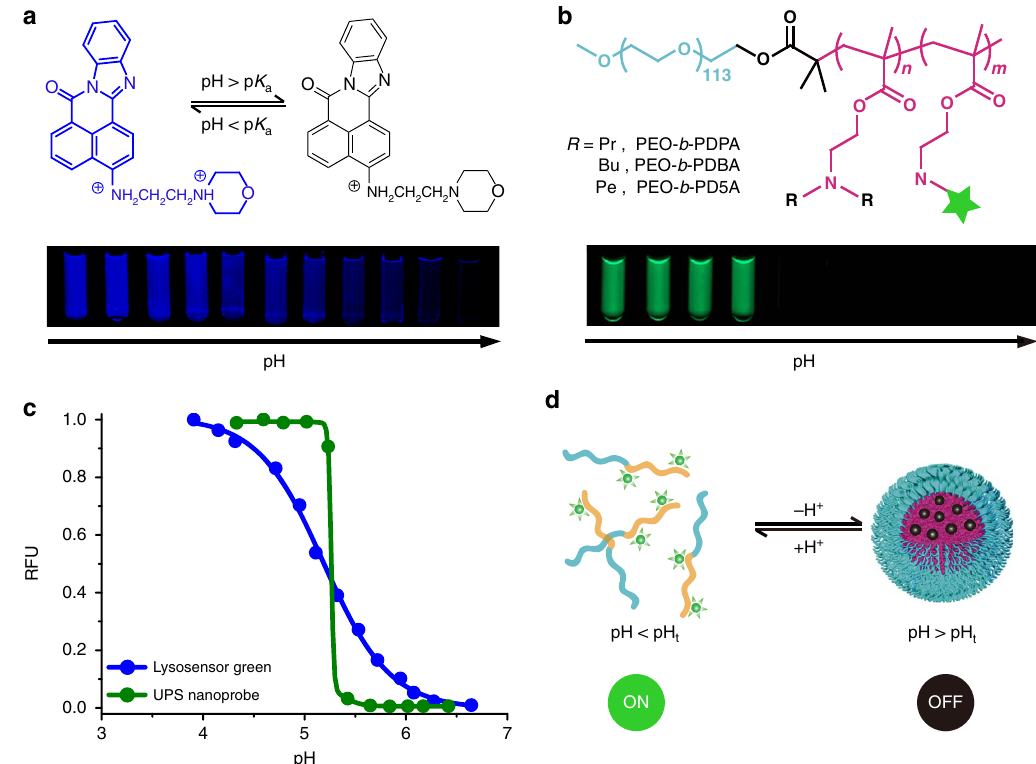
Figure 1 | Ultra-pH sensitive (UPS) nanoprobes with unique binary on/off response to pH. ( a ) Structure and fluorescence images of a small molecular pH sensor, Lysosensor Green in aqueous solution at different pH. ( b ) Structure and fluorescence images of a UPS nanoprobe, Rhodamine Green-conjugated PEO- b -PDBA block copolymers in aqueous solution at different pH. ( c ) Relative fluorescence intensity as a function of pH for Lysosensor Green and PEO- b -PDBA-RhoG nanoprobe. ( d ) Schematic illustration of pH-triggered binary on/off transition of UPS